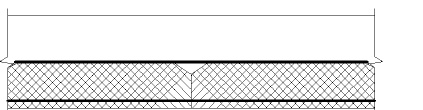
Figure 9. Overall seam form of the composite slab.